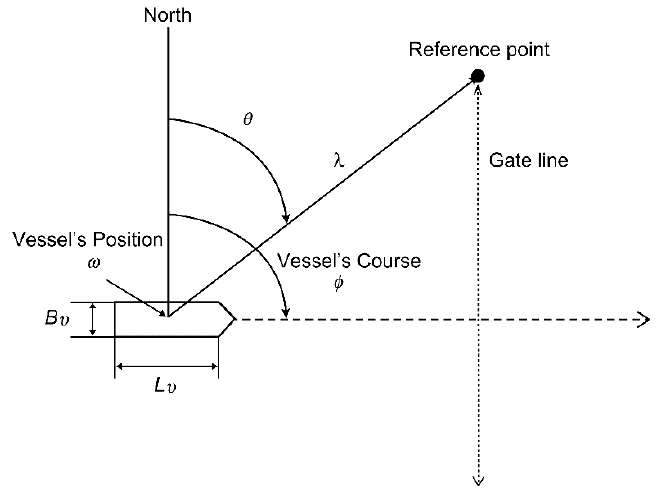
Figure 7. Distance between the vessel and the reference point.